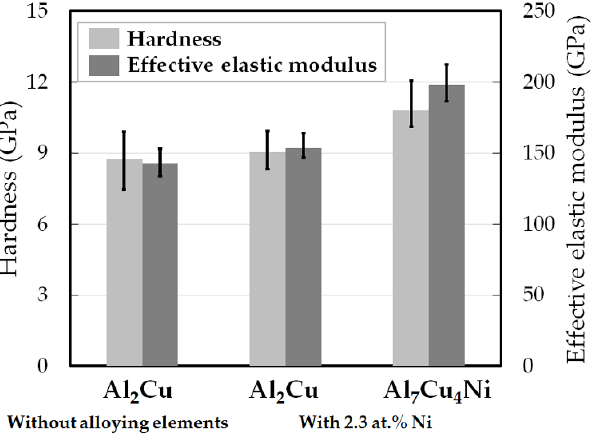
Figure 8. Hardness and effective elastic modulus of fractured IMCs in the Al/Cu dissimilar joints.